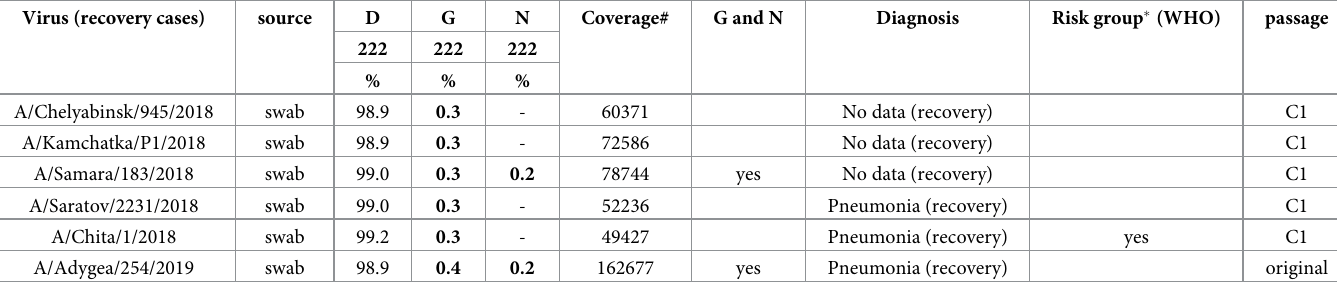
Table 7. Analysis of minor A(H1N1)pdm09 virus variants with HA D222G/N mutations in samples from influenza cases with recovery. Virus (recovery